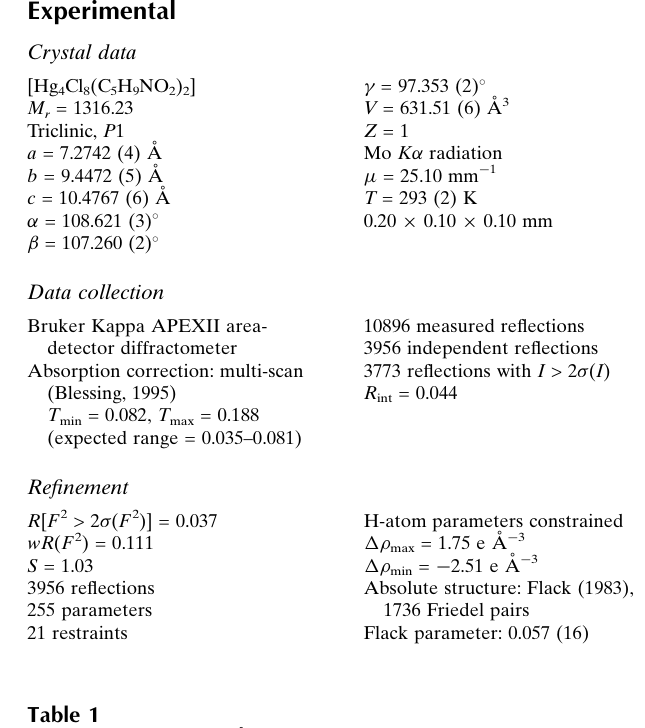
Selected bond lengths (A˚ ).